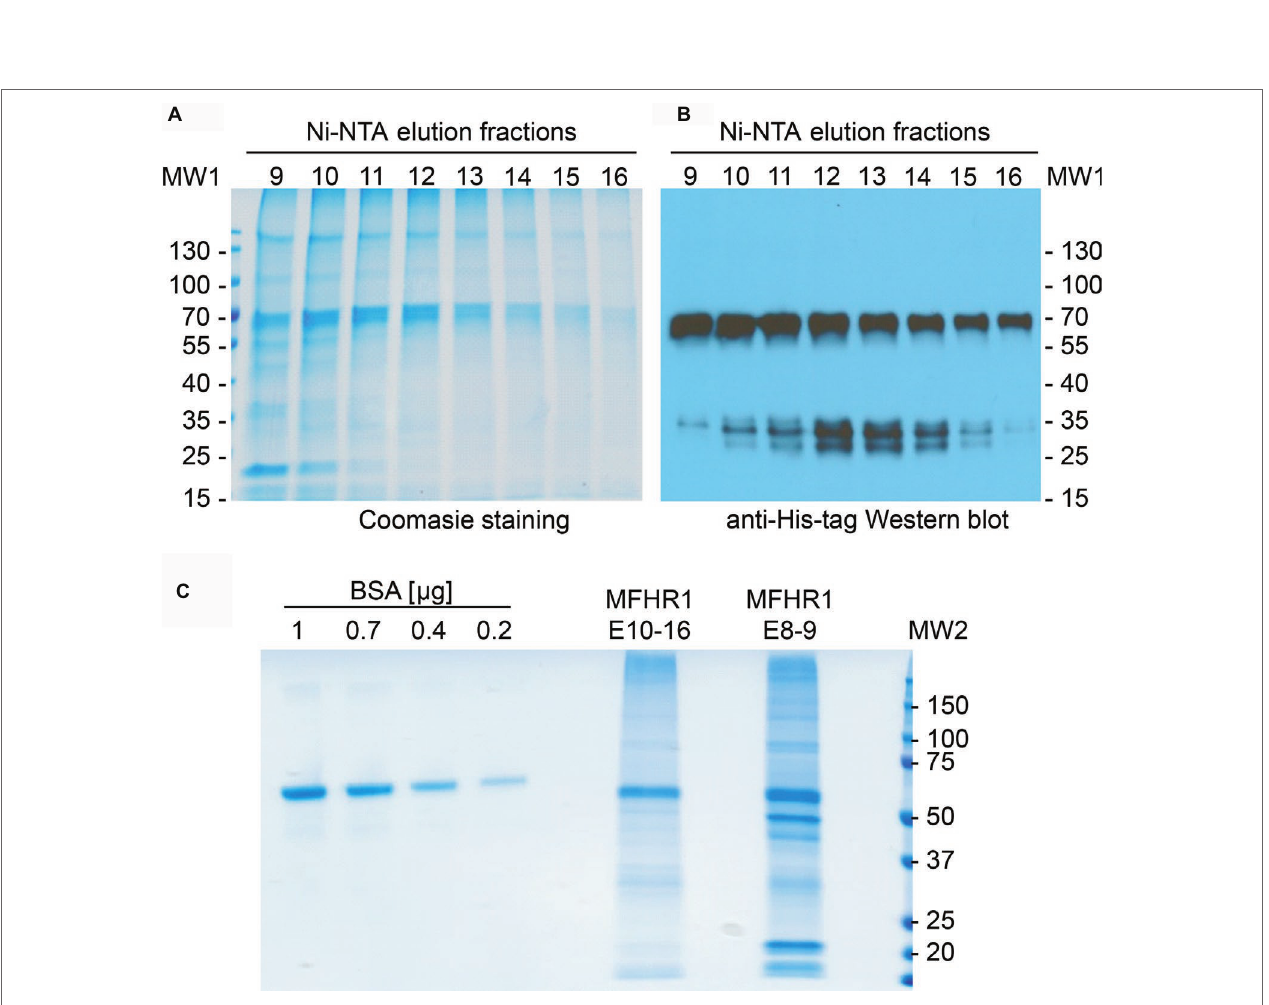
FIGURE 2 | MFHR1 production in the moss bioreactor. (A) Five liter photobioreactor setup of a Physcomitrella patens culture illuminated with LED lamps (in-house design). (B) Kinetics of MFHR1 concentration and biomass accumulation of the parental line Δ xt/ft and P1 in a culture carried out in the photobioreactor. The arrow marks the addition of 5 μ M NAA to the